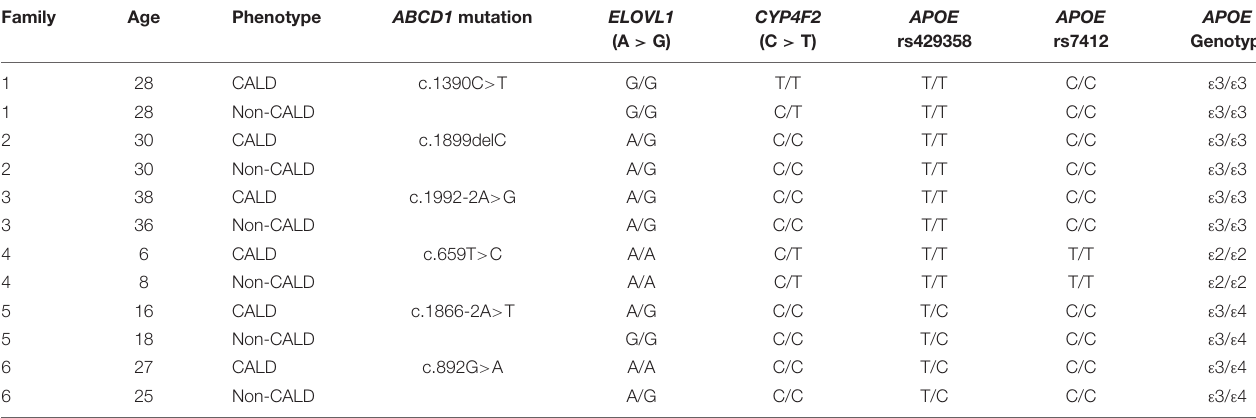
TABLE 1 | Summary of patients within ALD